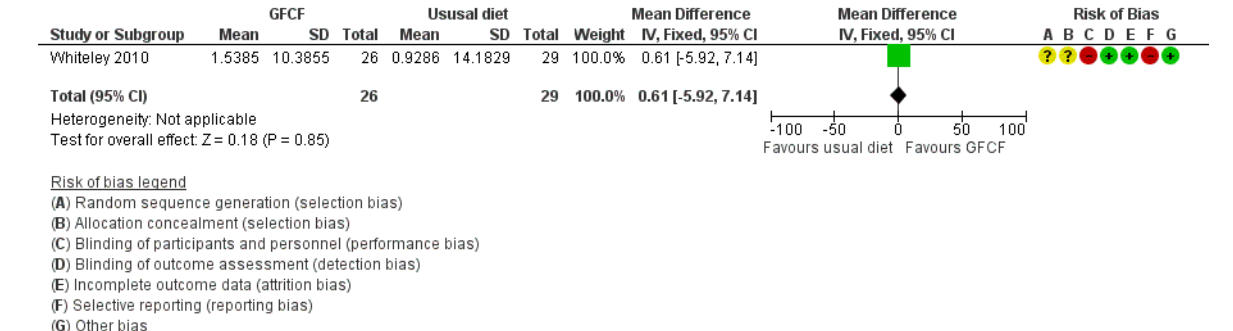
Figure 7. Forest plot of comparison: GFCF vs. usual diet, outcome: parent-reported functional level (VABS daily living, higher is better).